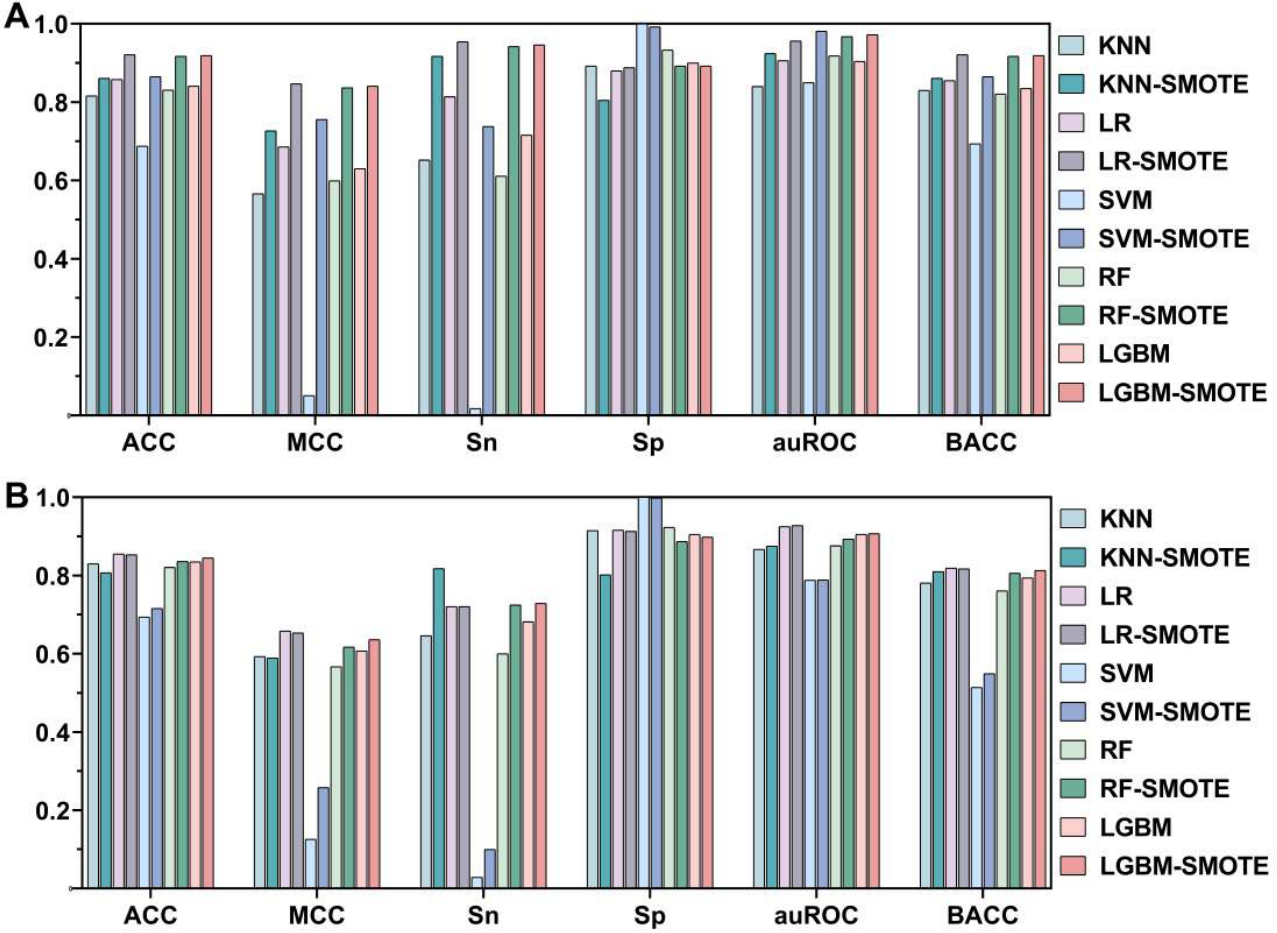
Figure 2. Results of 10-fold cross-validation ( A ) and independent testing ( B ) of the five ML models balanced with SMOTE and the five ML models balanced without SMOTE.As illustrated in Figure 2 and Supplementary Table S1, the features of models following optimization with SMOTE were clearly superior to the features of models developed without SMOTE optimization. Using the LR-based prediction model as an example, the LR-SMOTE model outperformed or equaled the LR model without SMOTE optimization in 66.7% of the metrics in 10-fold cross-validation and independent tests. Of the SVM-based models, the SVM-SMOTE model outperformed the SVM model developed without SMOTE optimization in 83.3% of the